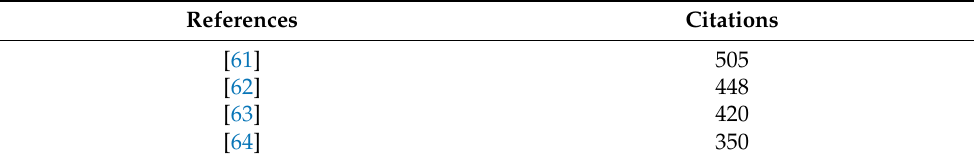
Table 9. Most cited articles on autism spectrum disorder and its relationship with parents (ASD-PAR).